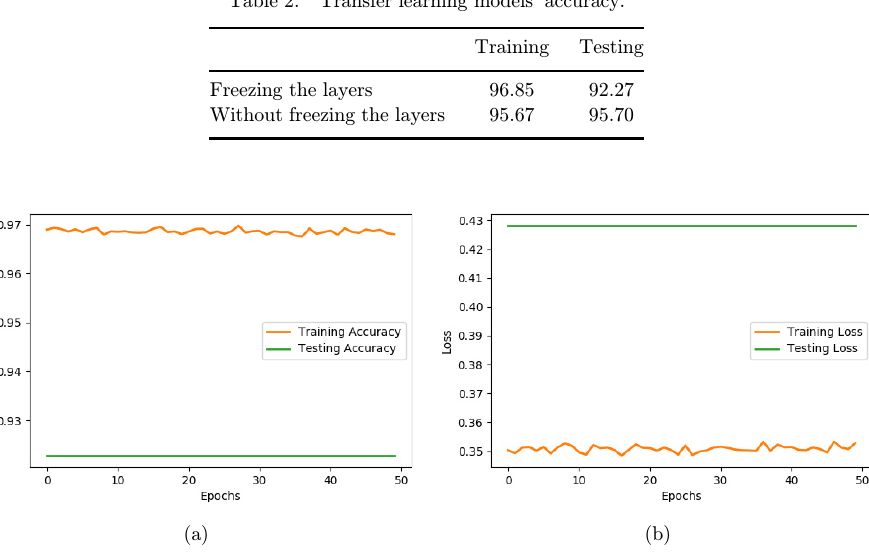
Fig. 6. Graph of the pretrained model without retraining (a) Epochs vs. Accuracy graph (b) Epochs vs. Loss.